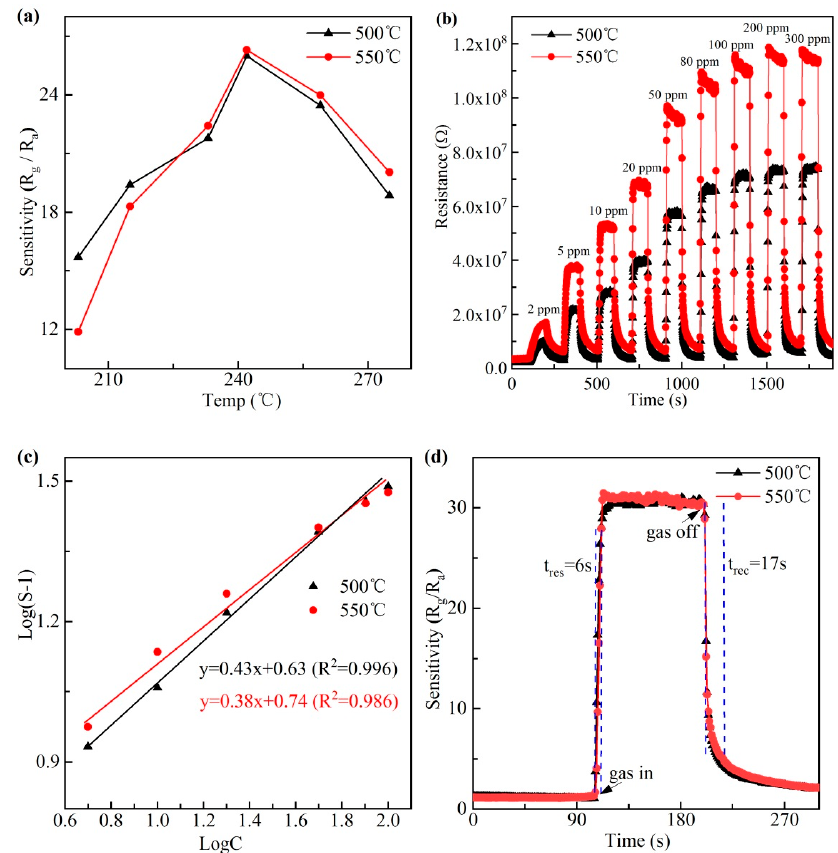
Figure 5. ( a ) Gas response of two BiFeO 3 sensors to 50 ppm isopropanol at di ff erent operating temperatures, ( b ) dynamic resistance-time gas response of two sensors to isopropanol at 240 ◦ C, ( c ) the corresponding log(S − 1) versus logC curves of two sensors, and ( d ) response time and recovery time of two BiFeO 3 sensors to 100 ppm